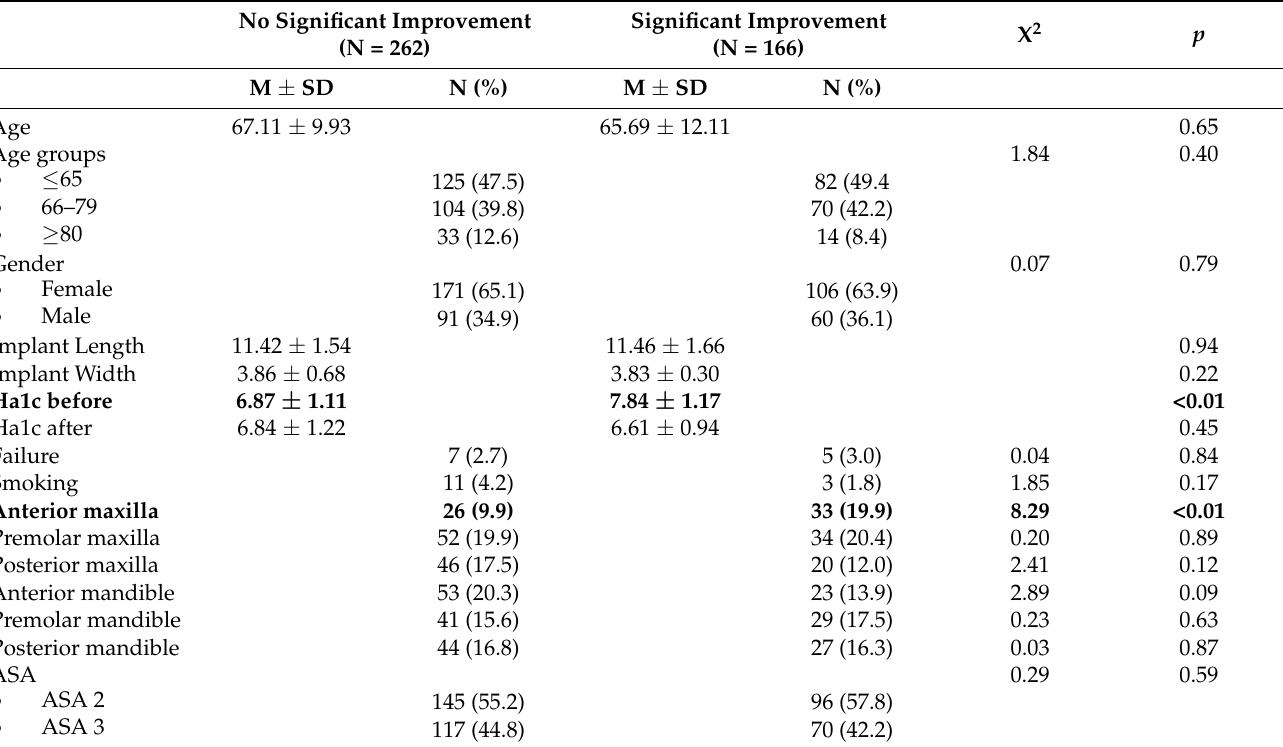
Table 5. Univariate analysis (implant level).